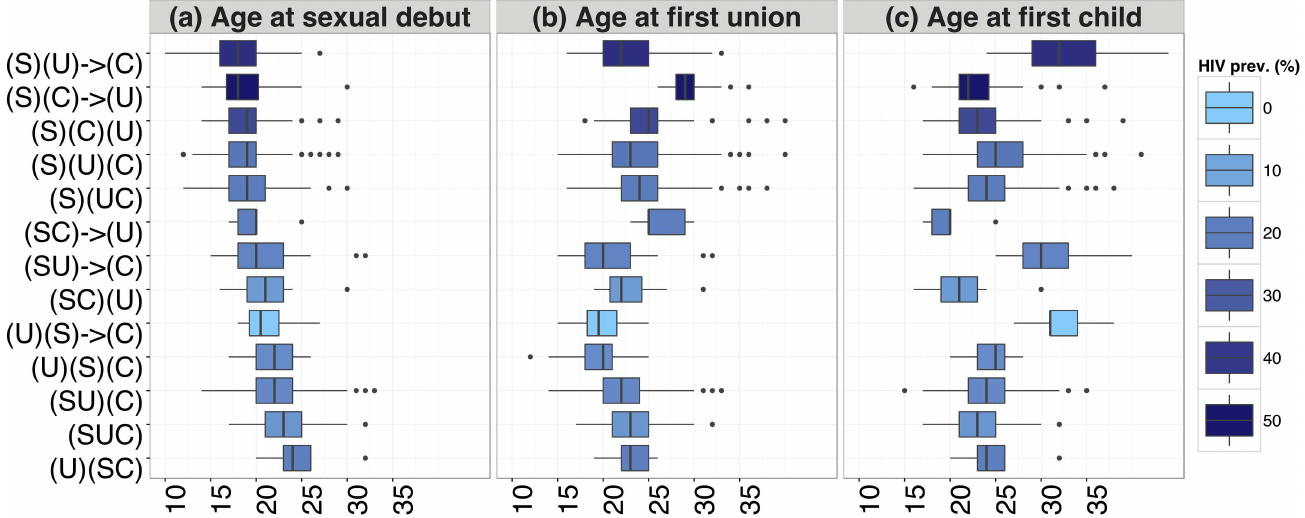
Fig 2. Age at events by sequence and HIV prevalence for men. Boxplot of the age at sexual debut, age at first union, and age at first child, by sequence, sorted by median age at sexual debut (in ascendingorder) and colouredaccordingto the HIV prevalence, Manicaland (Zimbabwe), 2000–